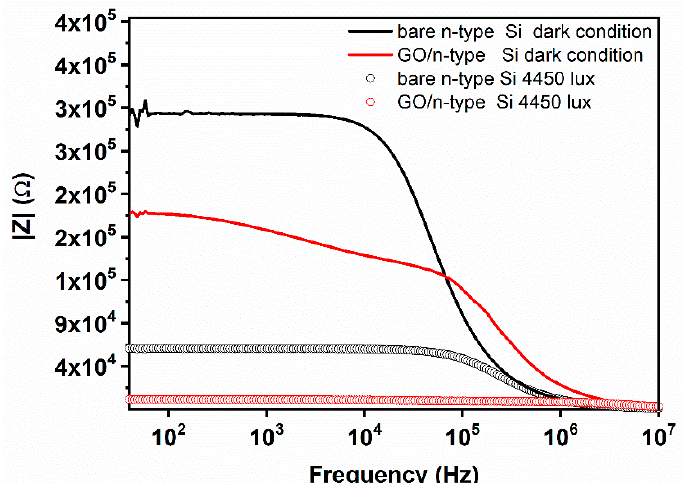
Figure 7. Impedance measurements on n-type silicon and graphene oxide/n-type Si samples under dark and light illumination conditions.